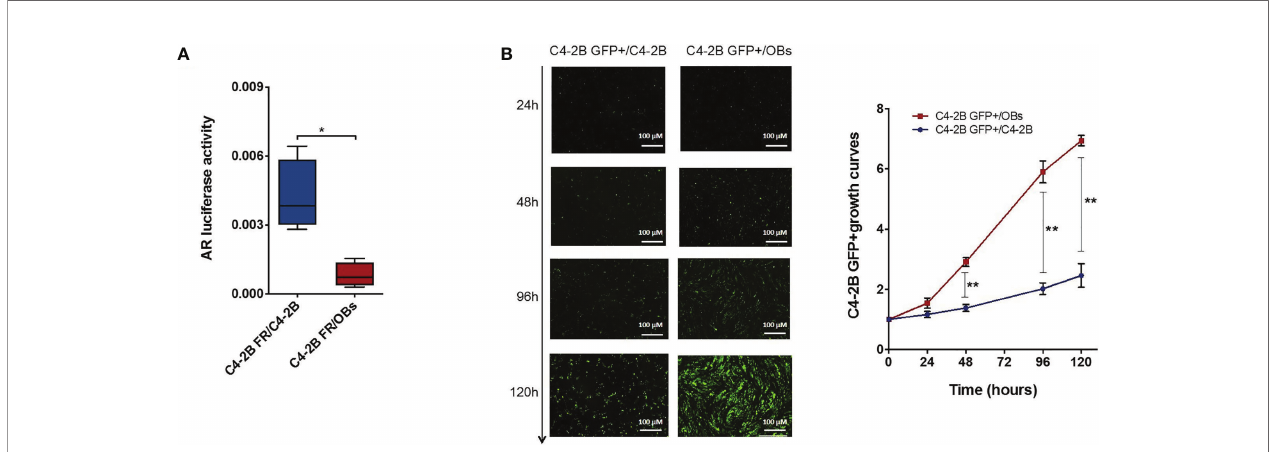
FIGURE 5 | AR activity C4-2B FR cells and proliferation analysis of C4-2B GFP+ cells in “ direct ” co-culture with OBs. (A) AR activity measured as fi re fl y luciferase signal normalized with Renilla luciferase signal (housekeeping control). (B) Representative images of direct co-cultures captured at 24, 48, 96, and 120 h after C4-2B GFP+ cell (green) seeding; scale bar = 100 m m. Proliferation curves C4-2B GFP+ cells co-cultured with OBs (red) or C4-2B as control (blue). GFP+ signal at each time point was normalized with GFP signal at baseline * p < 0.05; ** p <